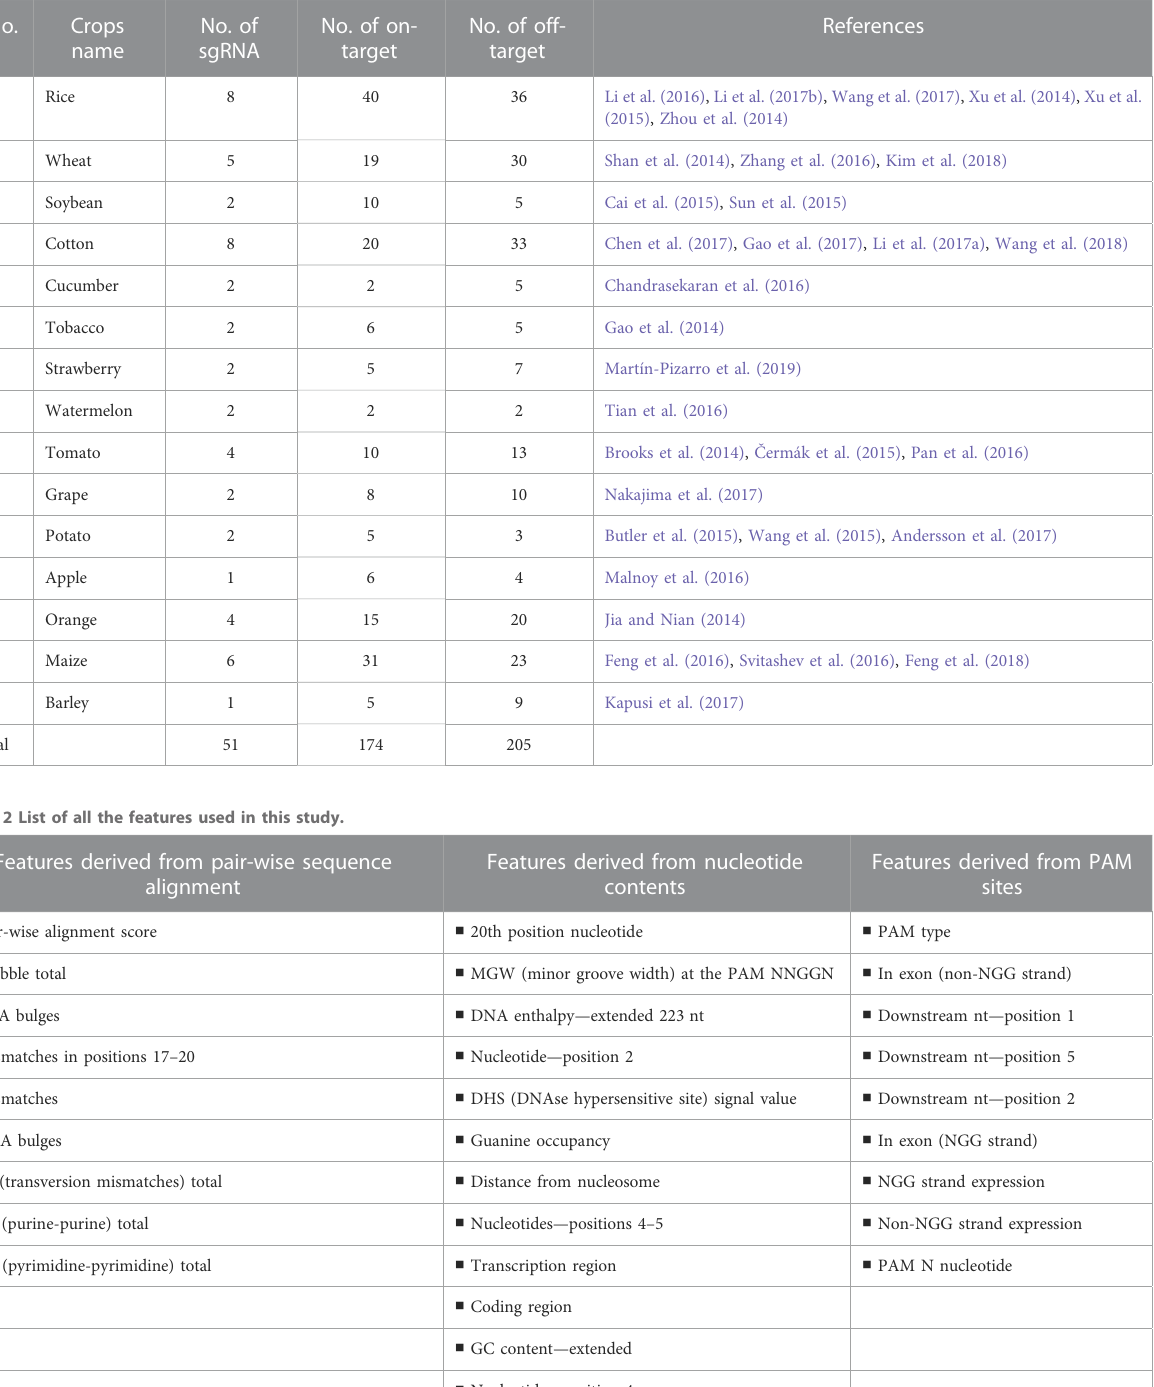
TABLE 1 Crop wise number of sgRNA, on-target and off-target. Sl. No.